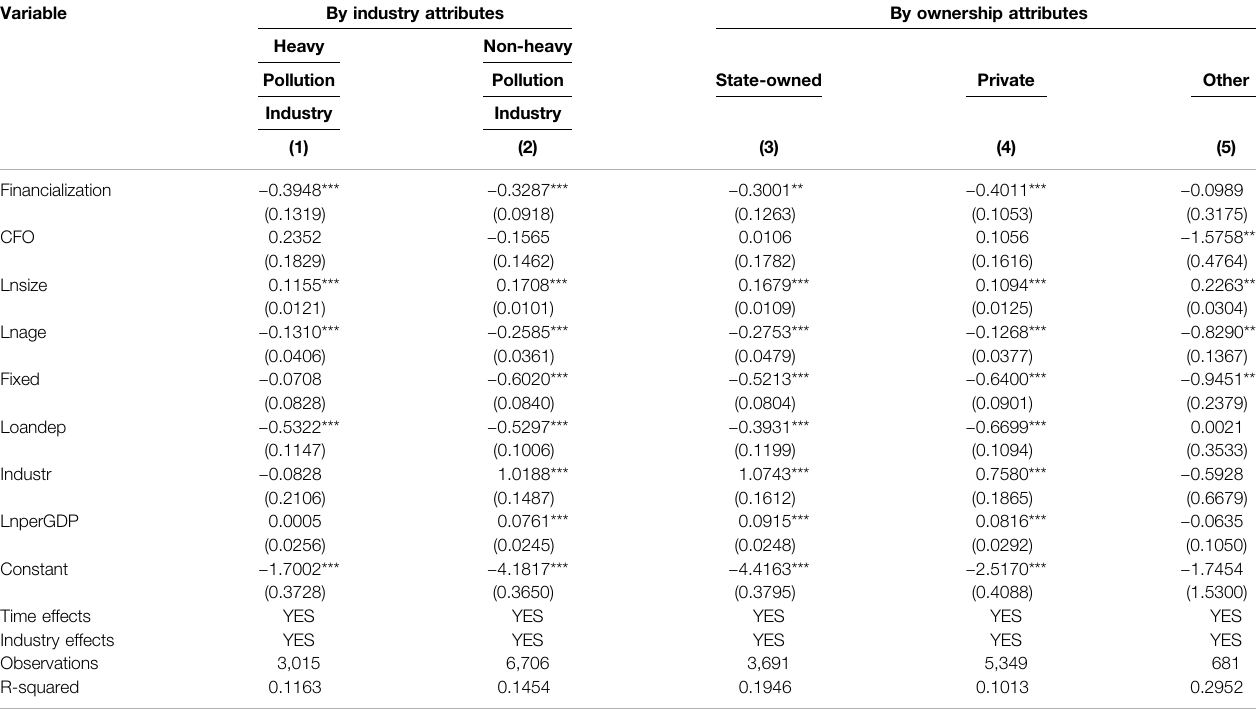
TABLE 5 | Estimation results of the impact of corporate fi nancialization on green technology innovation. Variable By industry